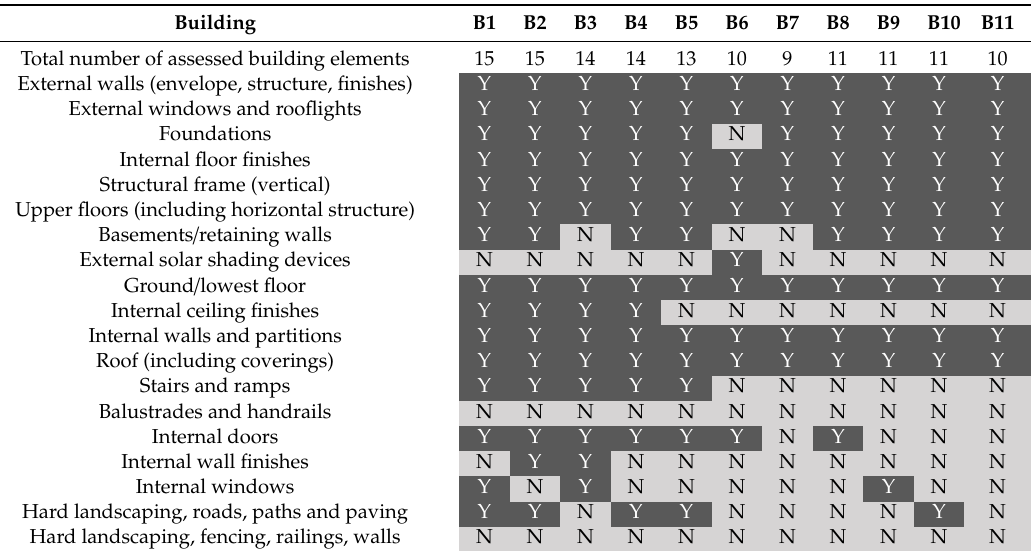
Table 6. Summary of assessed building elements.